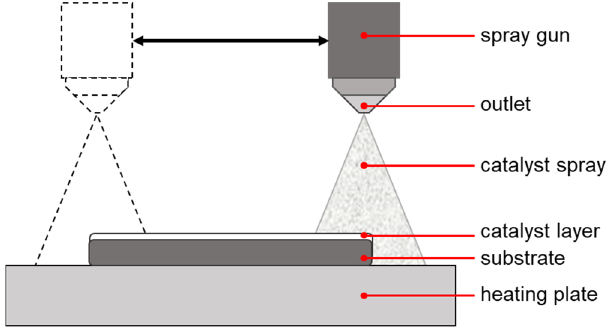
Figure 15. Schematic sideview of the spray coating process; arrow indicates the direction of movement.